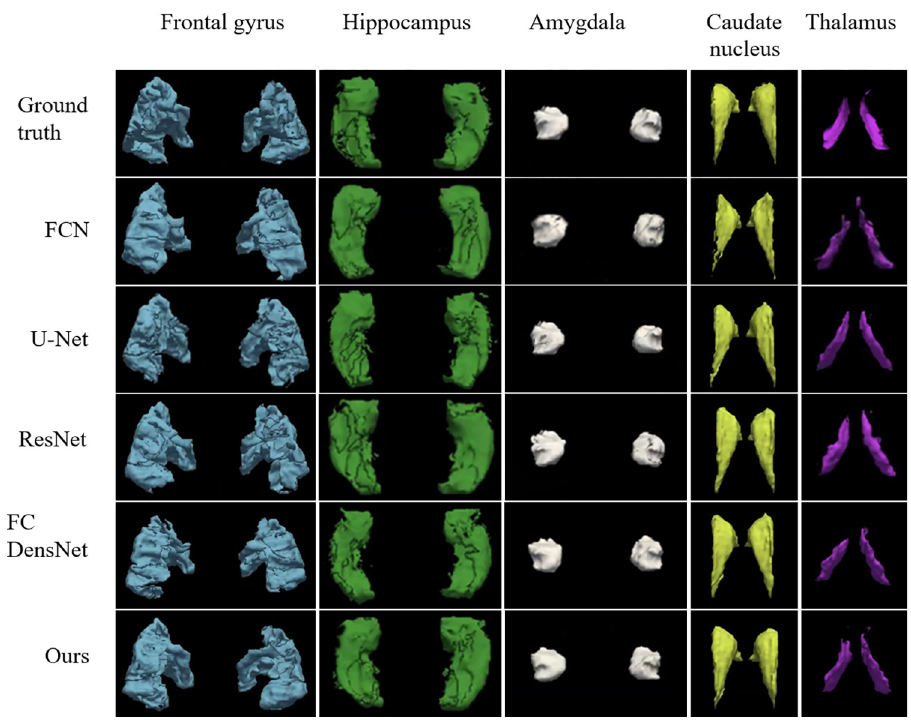
Fig 6. Examples of frontal gyrus, hippocampus, amygdala, caudate nucleus, thalamus segmentation results of FCN, U-Net, ResNet, FC DensNet and our method on the test dataset. The pixels in symmetrical brain regions are assigned the same label.